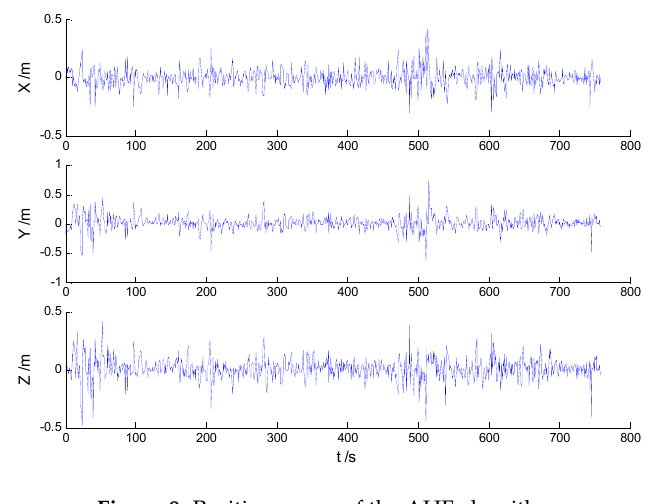
Figure 9. Position errors of the AHF algorithm.